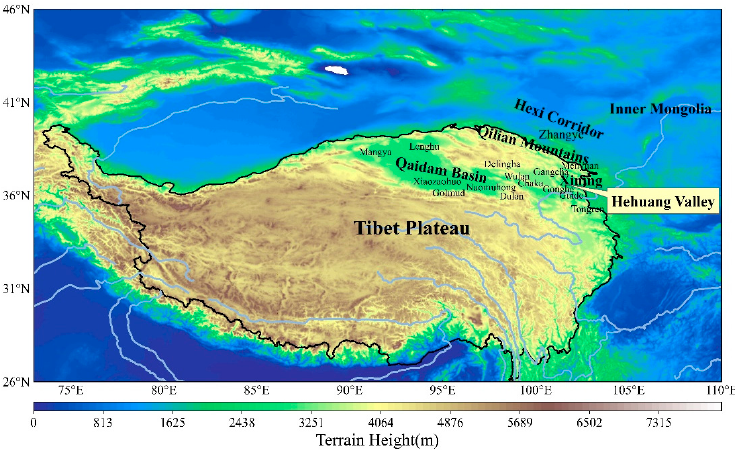
Figure 2. Terrain height of the Tibetan Plateau, geographical location of Qaidam Basin, Qilian Mountains, Hexi Corridor, Inner Mongolia, and the main meteorological observation sites.